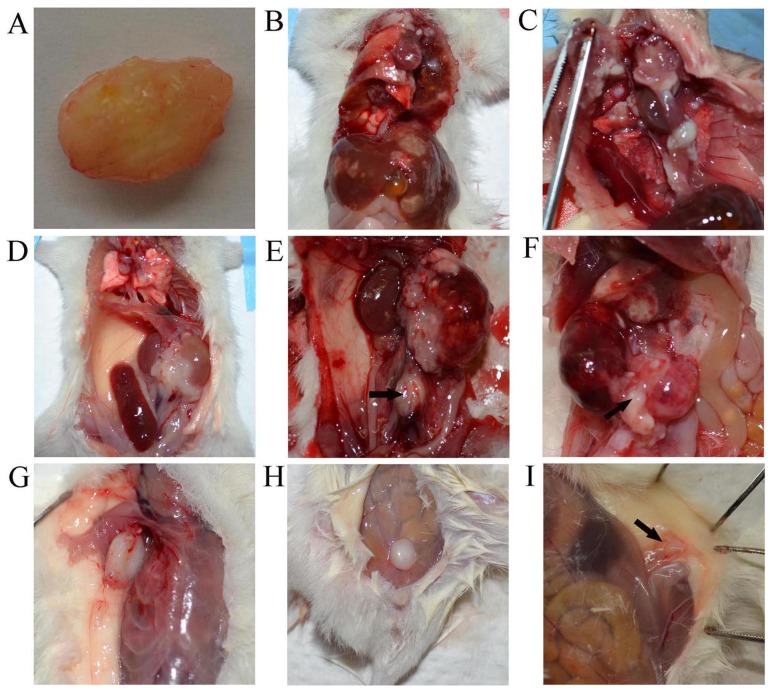
Histological features of primary tumors and metastatic tumors.A, the primary tumors (human xenografts) were formed by the subcutaneous injection of SK cells, and these tumors had a sarcomatous appearance (white color) lacking angiogenesis. B-I, metastatic tumors were found in different organs, such as liver (B), lung (C), spleen, kidney and ureter (D), kidney and ureter (arrow) (E), kidney, liver, and pancreas (arrow) (F), joint at chest and front leg (G), outer peritoneum (H), under skin (arrow) (I) (non-injection site).